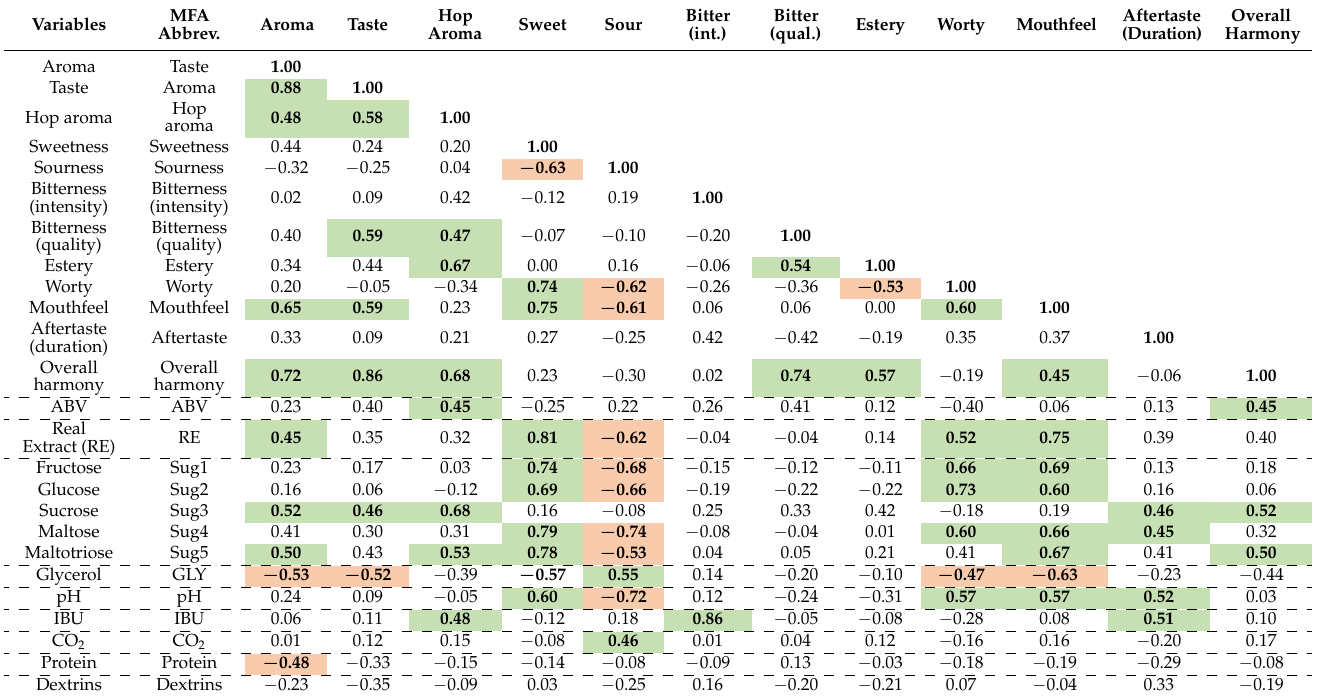
Table 3. Pearson correlation coefficients between sensory and physicochemical